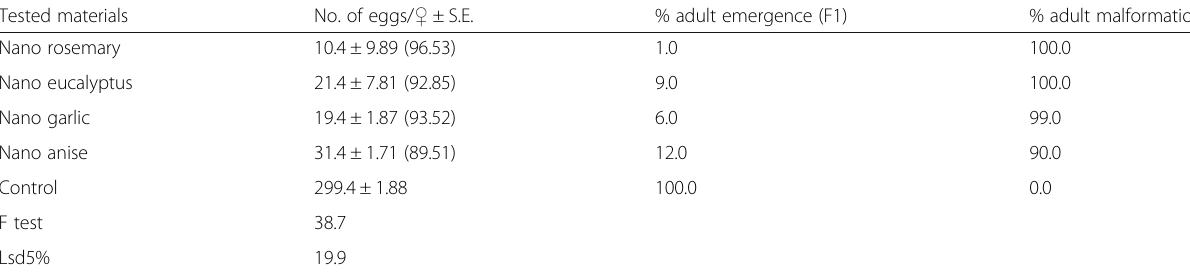
Table 2 Effect of nano oils on number of laid eggs/female, % adult malformation, and % of adult emergence (F1) of E. kuehniella during storage Tested materials